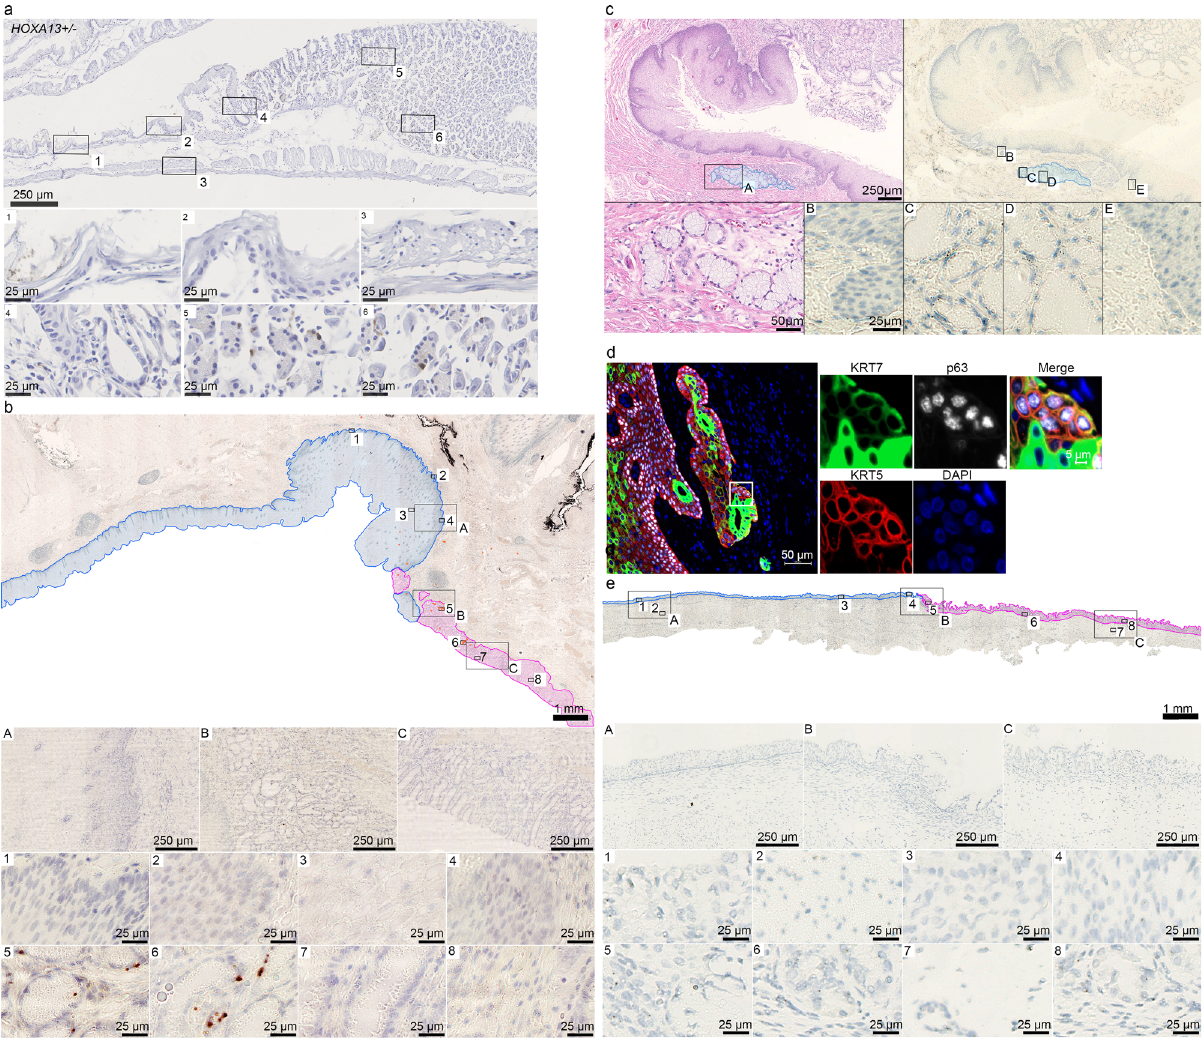
Fig. 4 HOXA13 expression in the upper GI tract. a Representative example of anti-GFP immunohistochemistry of a Hoxa13-GFP heterozygous mouse with gastroesophageal junctions (GEJ) (SQ; squamous epithelium, ST; stomach) ( n = 3). Hoxa13 is expressed in single cells of the stomach starting from the GEJ (5 – 6) and absent in the esophagus and stroma (1 – 4). b HOXA13 expression as measured by RNA ISH in a representative example from n = 3 with similar results of an adult human GEJ with magni fi cation panel of: A — esophagus, B — GEJ area, C — proximal stomach. Orange circles indicate the positive signal in the overview image. c HOXA13 expression as measured by RNA ISH in human esophageal submucosal gland (ESMG) with magni fi cation panel of: A — H&E, C,D — ESMG, B, E — squamous esophagus, n = 1. d Keratin 7 (KRT7), keratin 5 (KRT5) and p63 triple positive cells are found in the ESMG, n = 1. e Overview of a representative example of a 17-week old fetus GEJ: A) Strati fi ed esophageal epithelium of the distal esophagus (blue), B) GEJ area, C) gastric epithelium of the proximal stomach (pink), n =